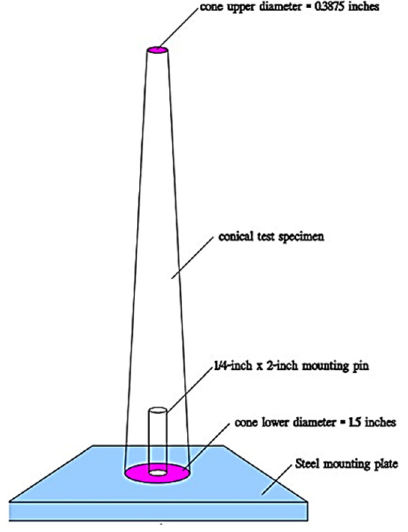
Figure 1. Sketch diagram of flammability test.